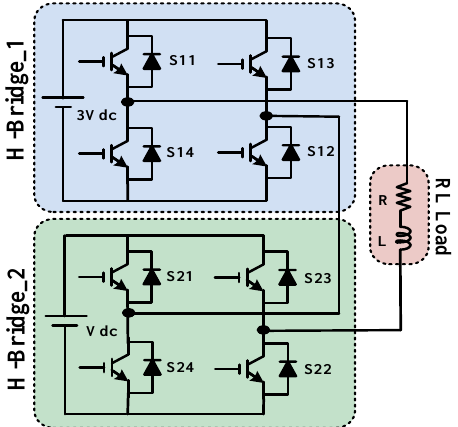
Figure 3. Cascaded H-bridge multilevel inverter.